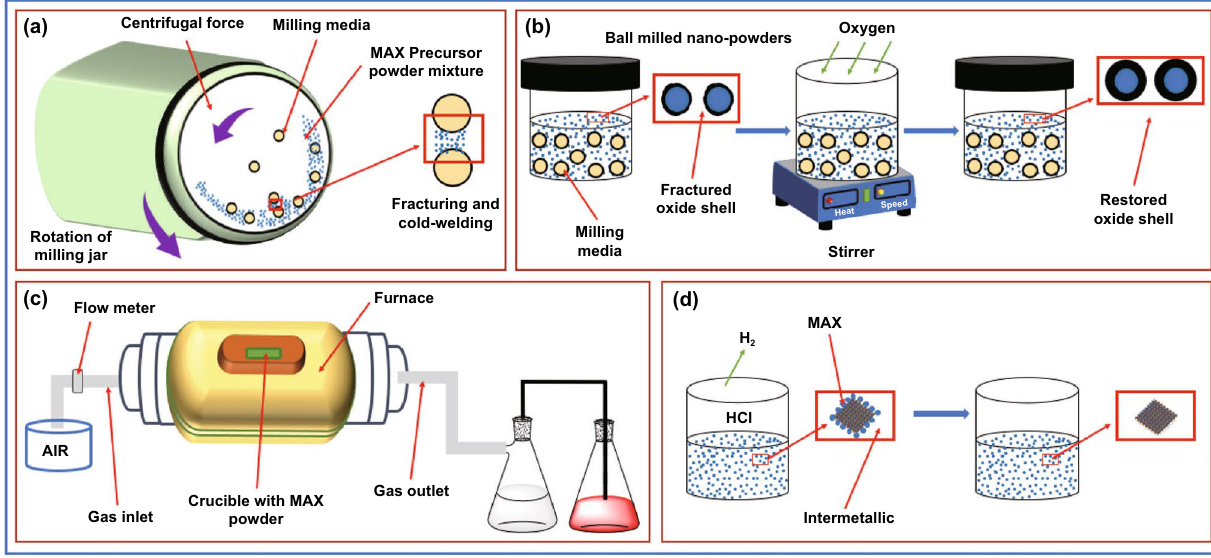
Fig. 5 Steps associated with the production of the MAX phase: a ball milling, b passivation by oxygen, c high-temperature synthesis, and d acid washing to remove